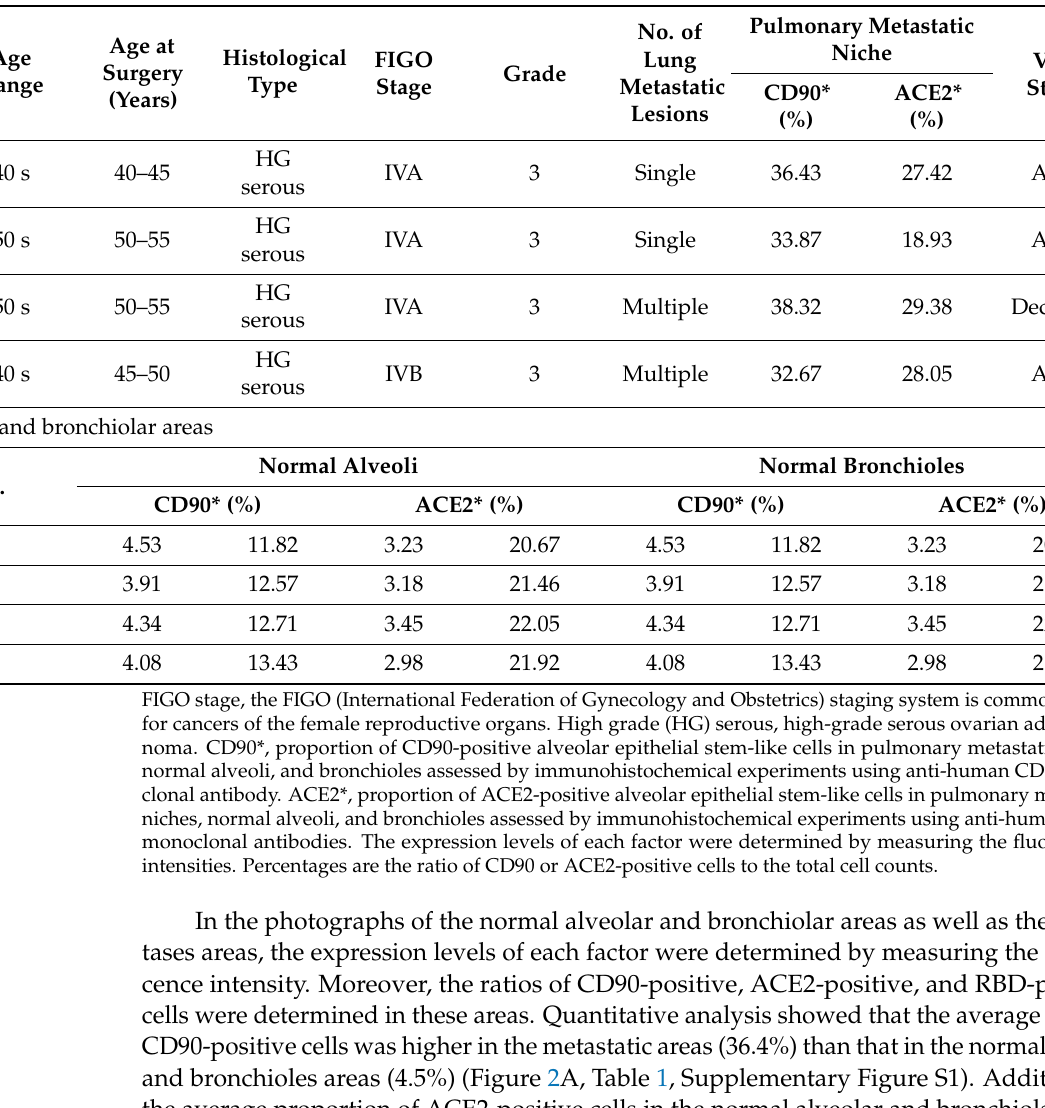
Table 1. Characteristics of patients with ovarian cancer and lung metastases as well as CD90 and ACE2 expression in the metastasis areas and the alveolar and bronchiolar